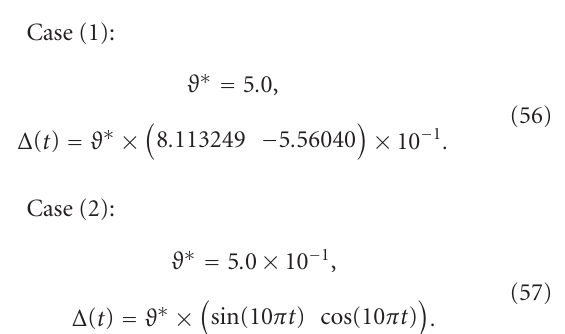
Figure 2: Time histories of the state variable x 2 ( t